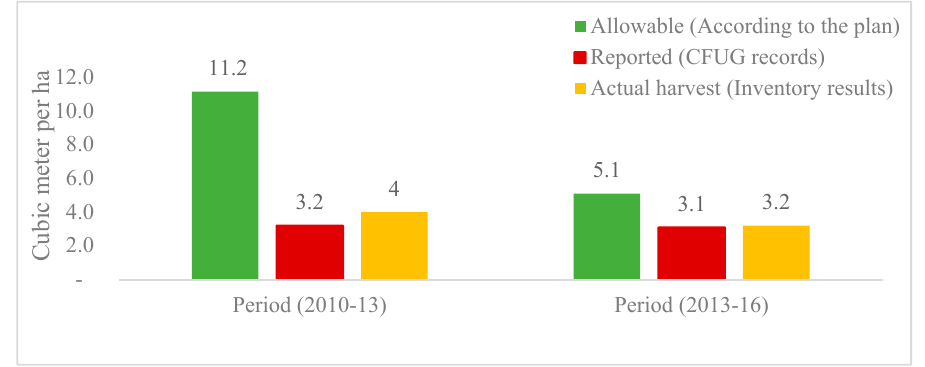
Figure 4. Reported and actual harvest compared to the allowable harvest. Source: Inventory result of 2010, 2013 and 2016, FMP and Inventory recorded.